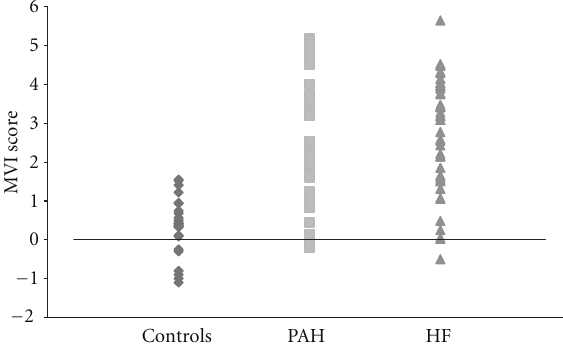
Figure 5: Range of MVI scores for patient groups and